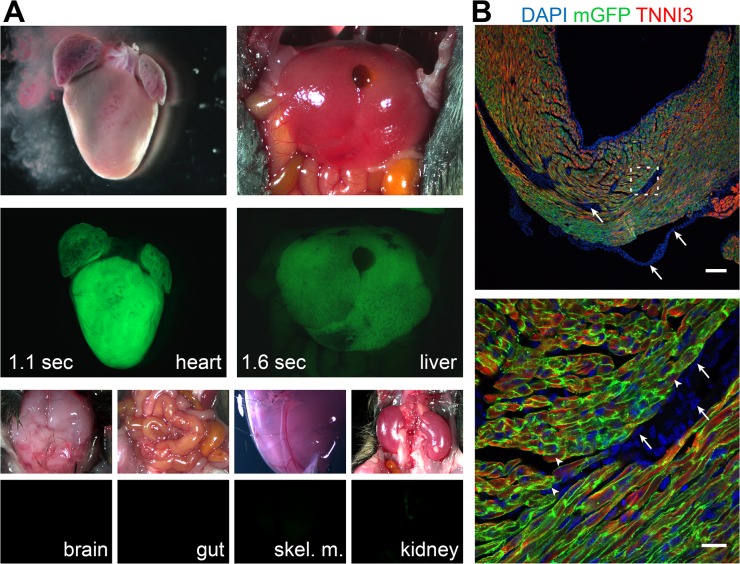
Cardiac-selective gene inactivation with AAV9-Tnnt2-Cre.AAV9-Tnnt2-Cre was administered to Rosa26mTmG neonatal mice. Cre recombination activates GFP expression. (A). Brightfield and GFP fluorescent signal from the indicated organs. skel. m., skeletal muscle. (B). Immunofluorescent staining of heart cryosections. Green indicates native membrane-localized GFP fluorescence. Cardiomyocytes were stained by TNNI3 (representative examples indicated by arrowheads). Boxed area in top image is magnified in the bottom image. Arrows indicate non-myocytes. Bar, 100 μm (C, top) and 20 μm (C, bottom).